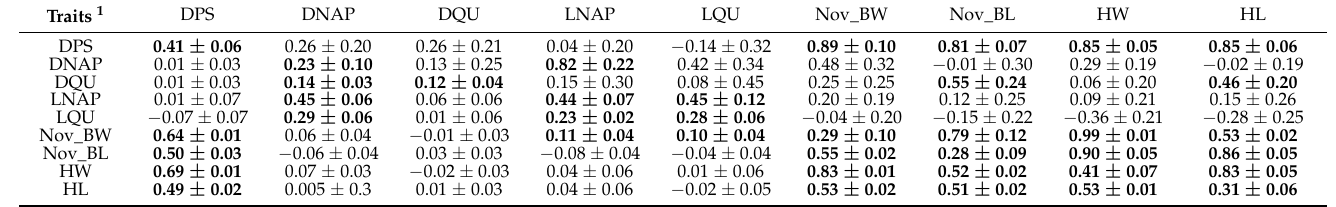
Table 4. Estimated heritabilities ( ± SE) (diagonal), genetic correlations (above diagonal) and pheno- typic correlations (below diagonal) for dried pelt, live grading and body weight and length traits in